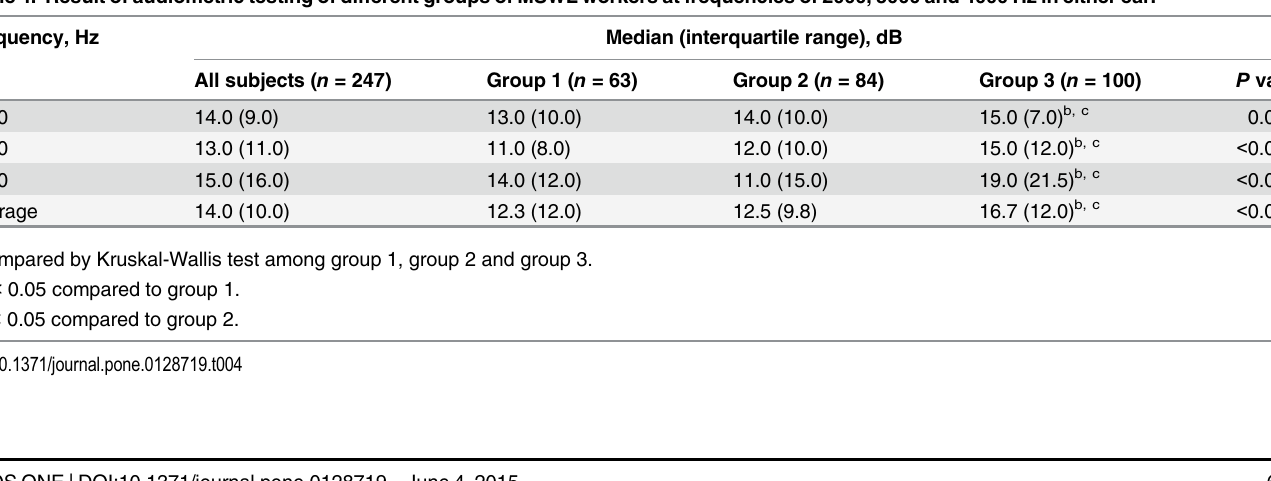
Table 4. Result of audiometric testing of different groups of MSWL workers at frequencies of 2000, 3000 and 4000 Hz in either ear. Frequency, Hz